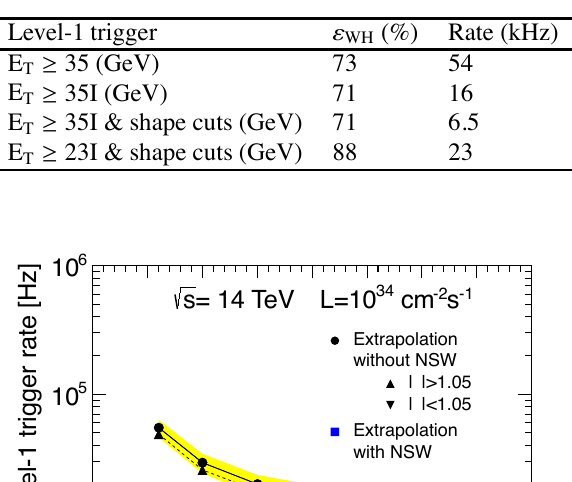
Table 2. The Level-1 trigger e ffi ciency for the W + H process ( ε WH ) and the corresponding estimated trigger rates for several conditions on the single EM cluster trigger. The “I” denotes the isolation selection. The shape cuts, realized through an upgrade, refer to requirements on the lateral shape on second sampling where the peak of the EM shower occurs.